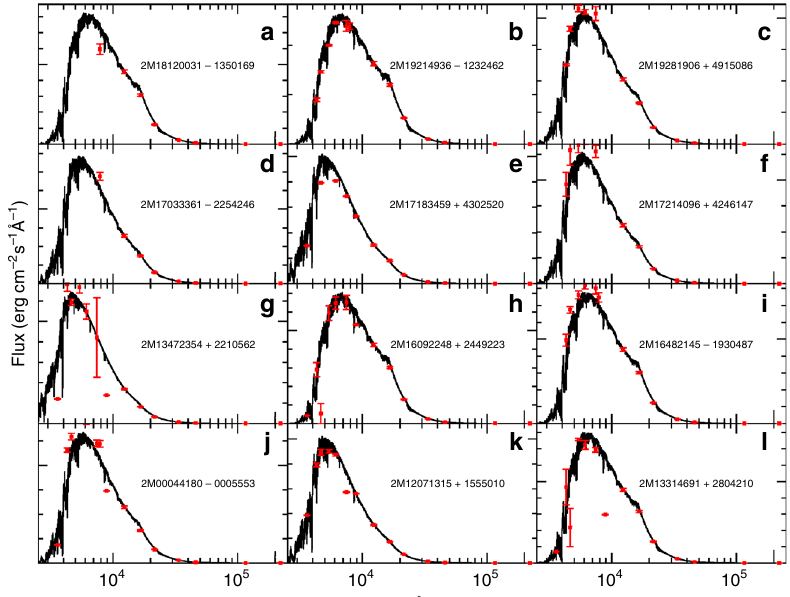
Fig. 5 Spectral energy distributions (SEDs) of the P-rich stars. The SEDs (broad band photometry from 2500 to 250,000Å in red) for 12 P-rich sample ( a – l ) stars are shown in comparison with the synthesized fl uxes (in black) with the derived stellar parameters and chemical abundances of each star. Error bars show the photometric measurement errors such as provided by VOSA.